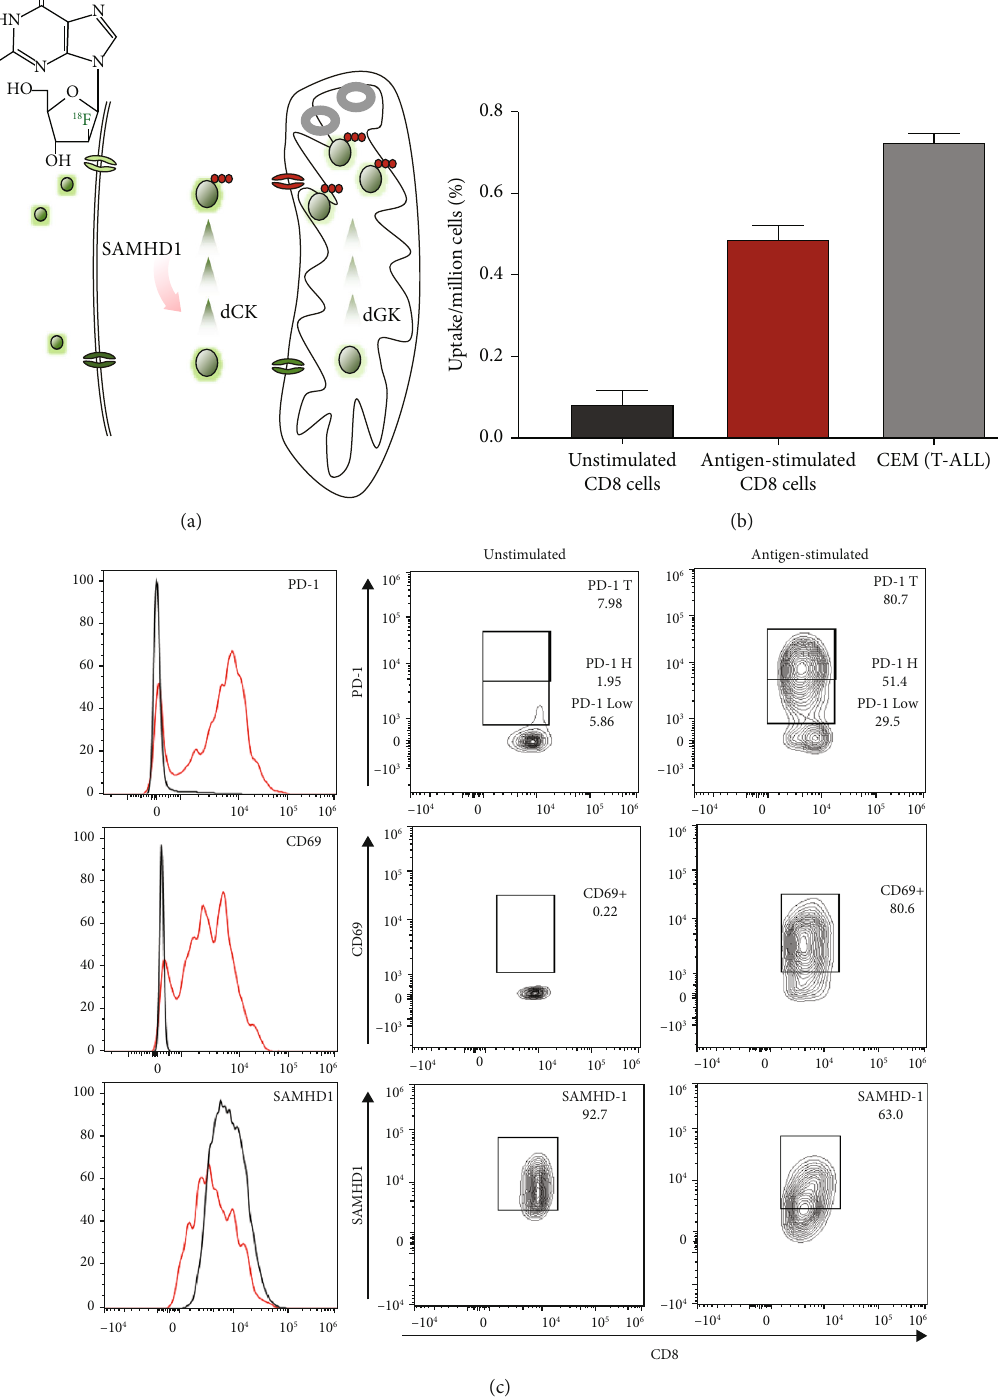
Figure 1: SAMHD1 and [ 18 F]F-AraG uptake in antigen stimulated T cells. (a) The proposed mechanism of uptake. [ 18 F]F-AraG is transported into cells via nucleoside transporters, followed by the rate-limiting phosphorylation by mitochondrial deoxyguanosine kinase (dGK). Once triphosphorylated, [ 18 F]F-AraG can be incorporated into mtDNA or be exported from mitochondria where SAMHD1 can dephosphorylate triphosphate providing an opportunity for the unphosphorylated [ 18 F]F-AraG to be exported from the cell. Overall, optimal trapping of [ 18 F]F-AraG may be achieved in cells with high mitochondrial biogenesis and low expression of SAMHD1. (b) Accumulation of [ 18 F]F-AraG in CEM, unstimulated and antigen-stimulated T cells. Antigen-stimulated T cells show 6-fold higher uptake than the unstimulated T cells. T-ALL CEM cells served as a positive control and showed the highest accumulation of tracer. (c) Antigen-stimulated CD8 cells (red line) show higher levels of PD-1 and CD69 and lower levels of SAMHD-1 than unstimulated cells (black